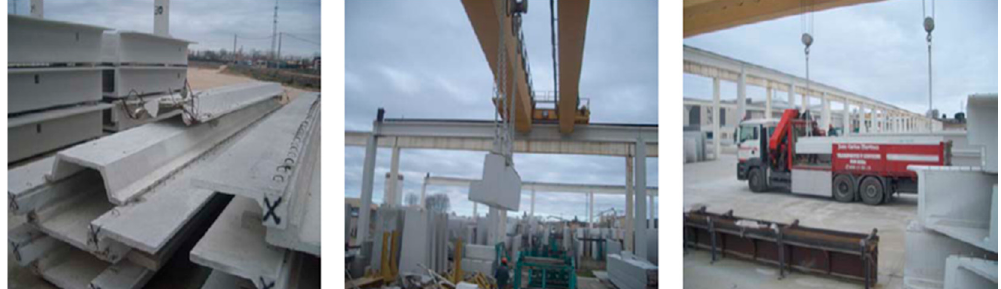
Figure 1 . Rejected recast products. Figure 1. Rejected recast